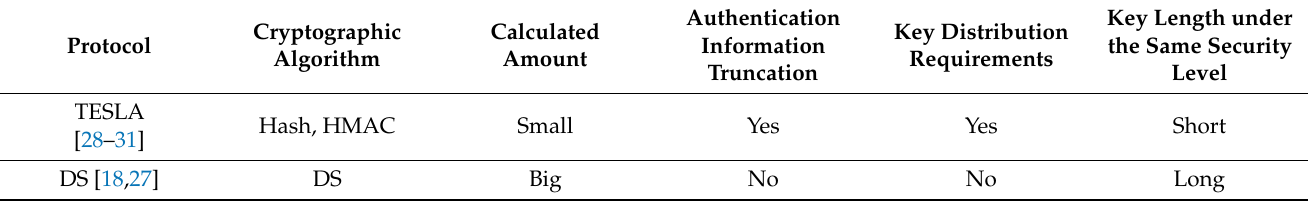
Table 2. Comparison of TESLA and ECDSA.